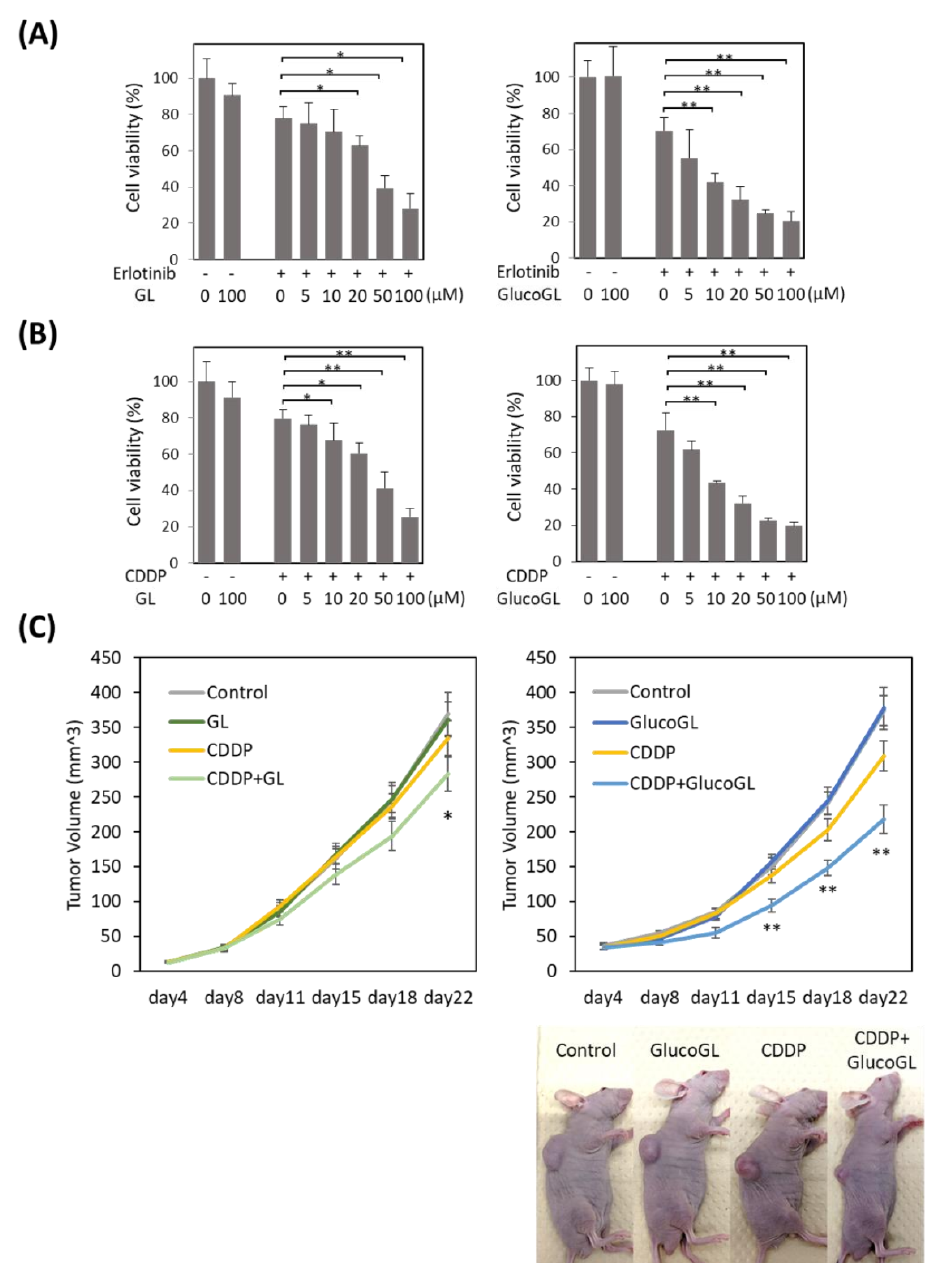
Figure 6. GL derivatives enhance chemosensitivity in HCT116 cells. Erlotinib ( A ) or cisplatin (CDDP) ( B ) was incubated for 12 h with HCT116 (control) cells treated with GL or GlucoGL, and cell viability was examined using MTT assay. The data represent the mean ± SE of three separate experiments. * p < 0.05 or ** p < 0.01 using Student’s T -test. ( C ) HCT116 (control) cells were injected subcutaneously into the flanks of each nude mouse to initiate tumor growth for 22 days. The mice were then intraperitoneally treated with either control vehicle, CDDP (2 mg/kg), GL (400 mg/kg), or CDDP (2 mg/kg) and GL (400 mg/kg) (left panel), or CDDP (2 mg/kg), GlucoGL (100 mg/kg) or CDDP (2 mg/kg) and GlucoGL (100 mg/kg) (right panel) twice a week for a total of 22 days. Tumor volume was measured twice a week in three dimensions throughout the study. Data represent the mean ± SE of three separate experiments. * p < 0.05 and ** p < 0.01 using Dunnett’s